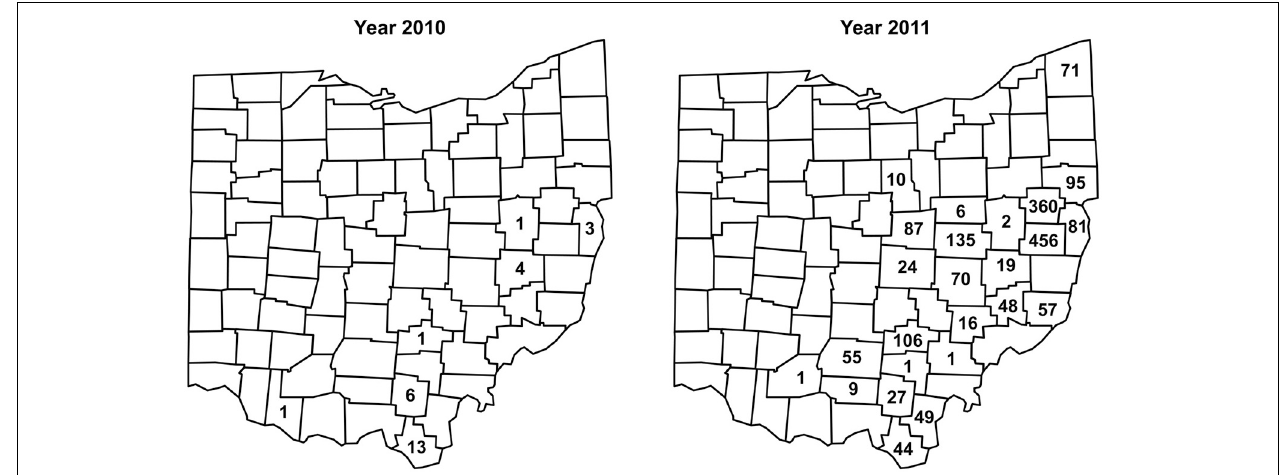
FIGURE 2 | Numbers and distribution of I. scapularis found on deer heads through the CWD surveillance program in 2010 and 2011.